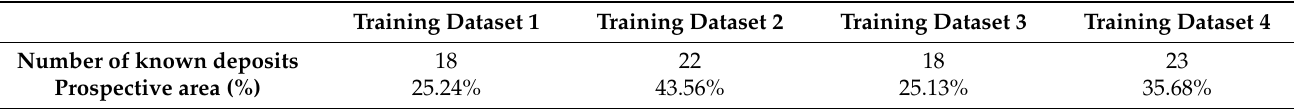
Table 7. Statistical results for the GA–SVM